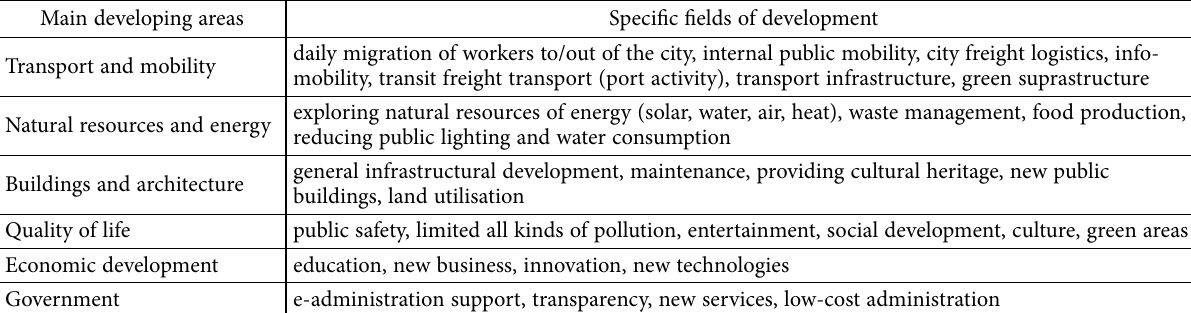
Table 2. Main areas and fields of SC development (source: summary of different research) Main developing areas Specific fields of development Transport and mobility